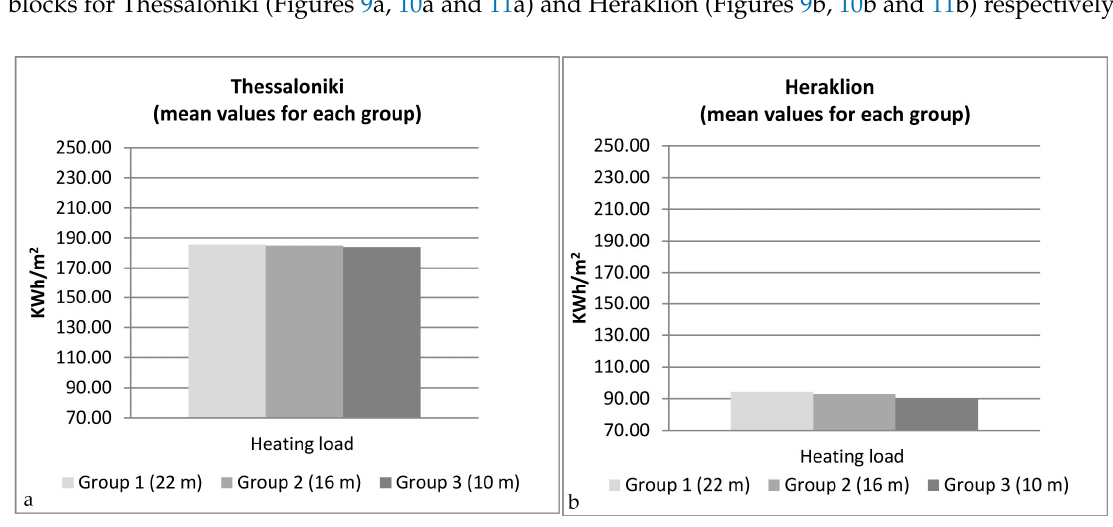
Table 5. Mean values for heating, cooling and total load demand, their absolute value of difference and the absolute percentage of difference for Thessaloniki and Heraklion climatic conditions.